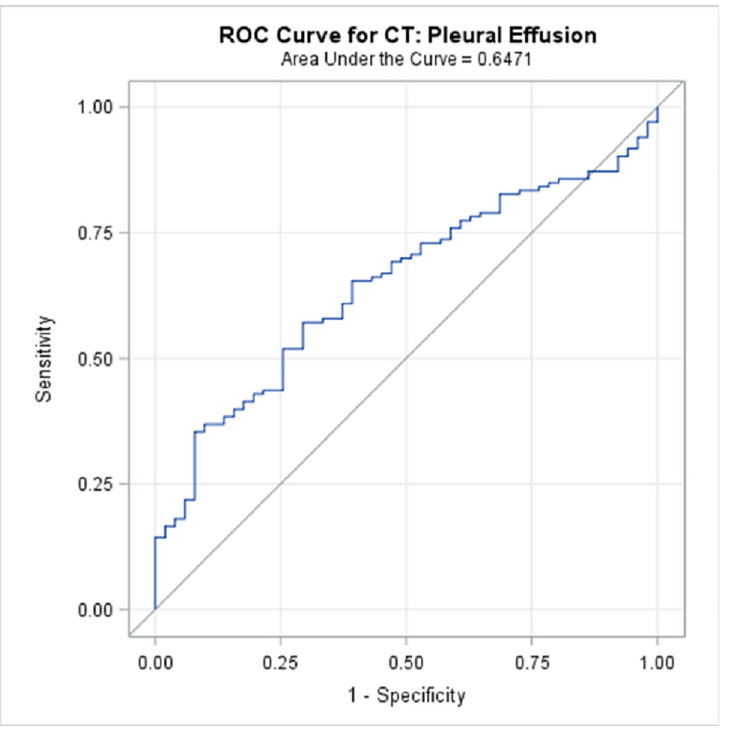
Fig 9. ROC Curve for CT: Pleural Effusion.